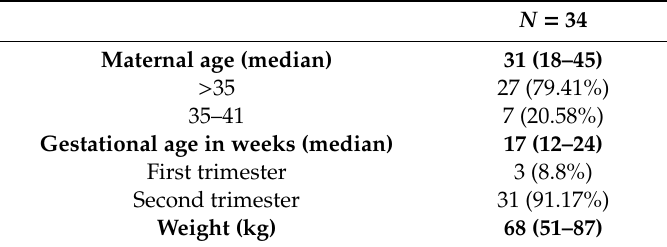
Table 1. General characteristics of samples